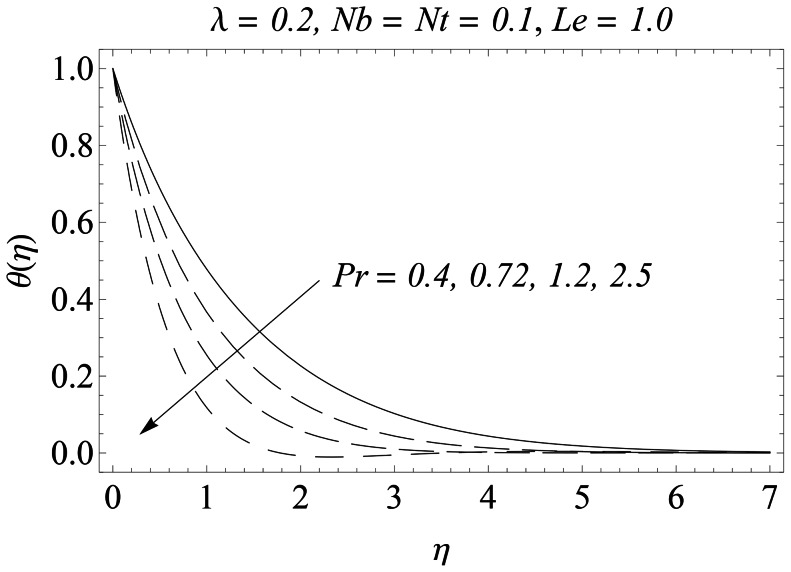
Influence of Pr on .